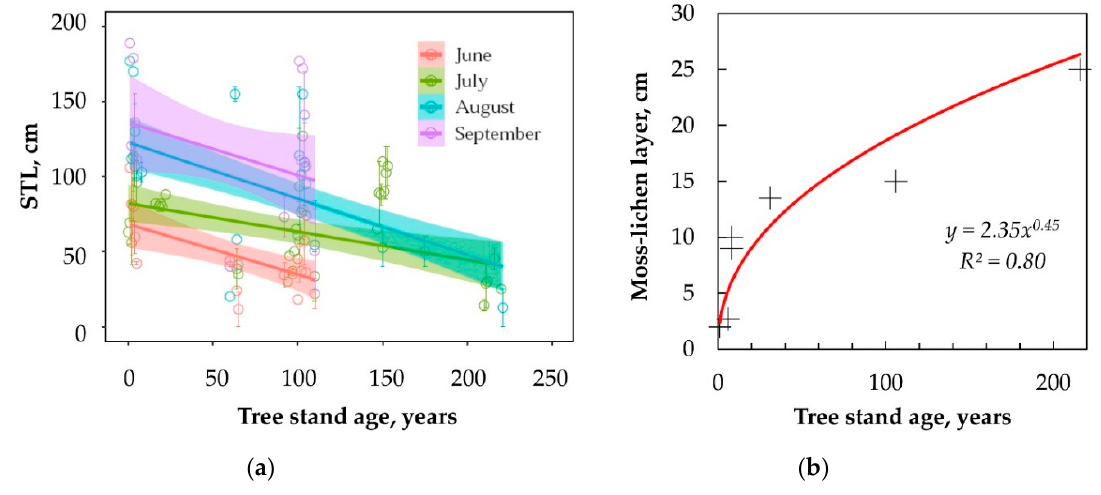
Figure 4. Data preprocessing of the STL and moss–lichen layer from the field dataset. ( a ) Relationship between STL (mean ± SE) and tree stand age in different months of the growing season (June − September). Shadows represent confidence intervals (standard error). ( b ) Post-fire moss–lichen layer recovery.